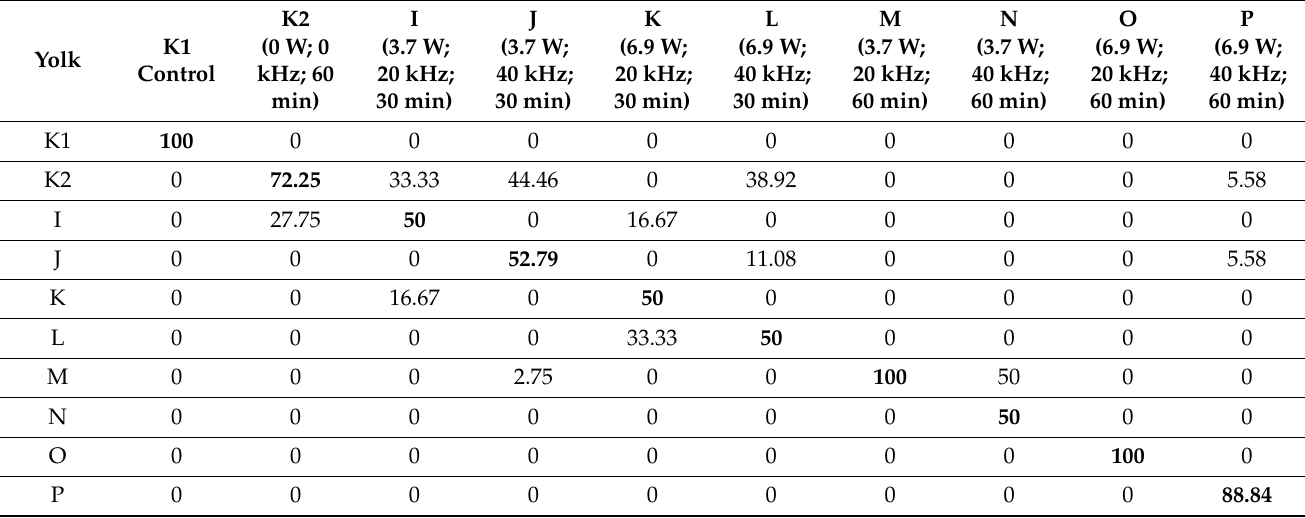
Table 5. Classification accuracy of linear discriminant analysis of yolk samples,